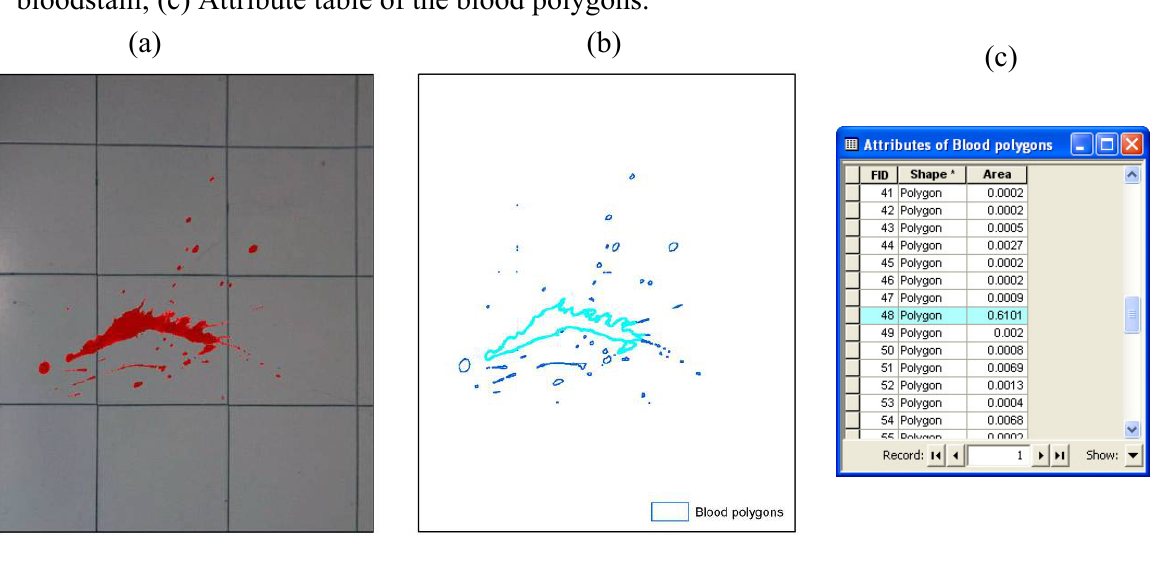
Figure 8. (a) Bloodstain identified on the rectified image; (b) Vector classification of the bloodstain; (c) Attribute table of the blood